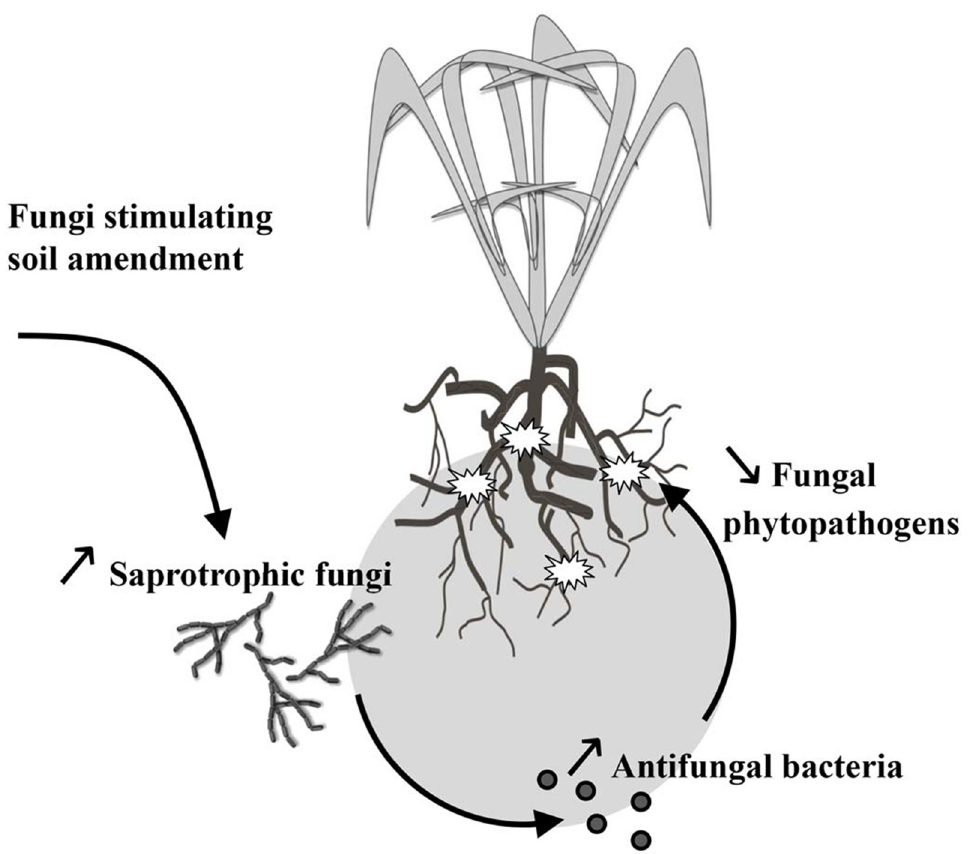
Fig 5. Schematic illustration of possible stimulation of biocontrol of soil-borne pathogenic fungi by increase of saprotrophic fungi. Organic amendments and/or other measures that stimulate growth of saprotrophic fungi can result in an increase of uptake of rhizodeposits by these fungi and, consequently, in an increase of competitive fungal pressure towards rhizosphere bacteria. As a result bacteria that are antagonistic against fungi will increase and several of these bacteria may also be antagonistic against soil-borne pathogenic fungi and form a natural barrier against fungal diseases. An advantage over introduction of antifungal biocontrol strains is that the fungus-induced stimulation occurs in situ with indigenous soil bacteria that are adapted to the local environmental